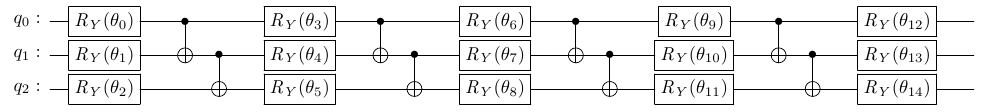
hardware efficient ansatz of Eqs. (18) and (19) with y